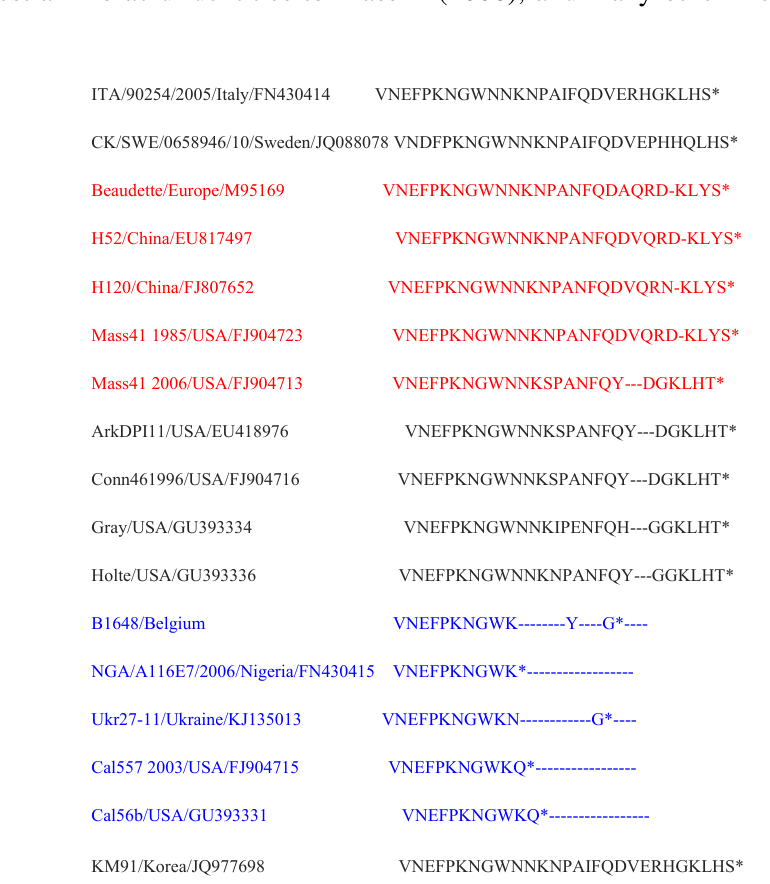
Figure 4. Amino acid sequence differences in C-terminal of E protein of B1648 strain with other Mass (red) and non-Mass type strains. In the B1648 strain 3′ terminal E (3c) protein, a region of total 12 amino acids was discontinuously deleted (blue). The dashes (-) indicate the deleted sequences.